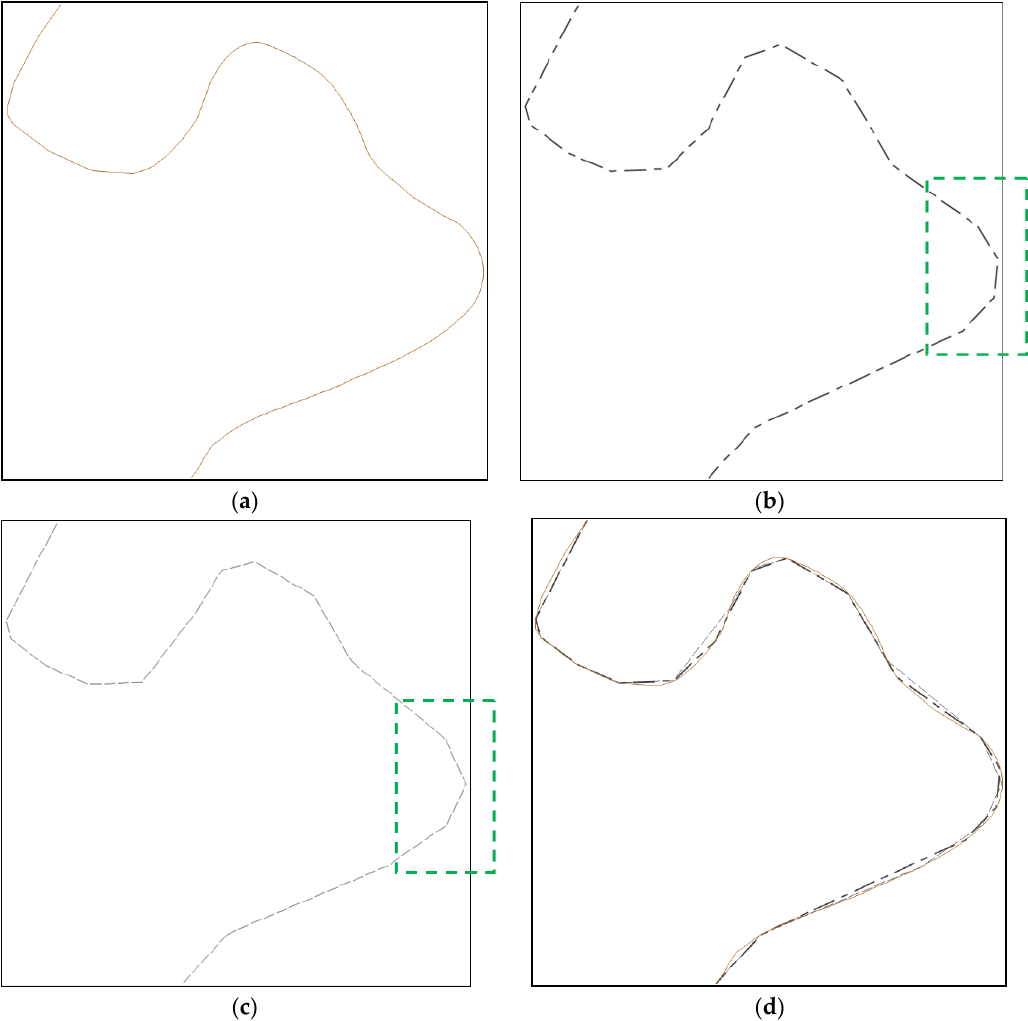
Figure 16. The simplified results based on the same cartographic line with different methods: ( a ) the initial line (with 88 shape points); ( b ) the simplified result based on the ODC method (with 17 shape points remained); ( c ) the simplified result based on the division at inflection points (with 17 shape points remained); and ( d ) the comparison of different simplified lines.